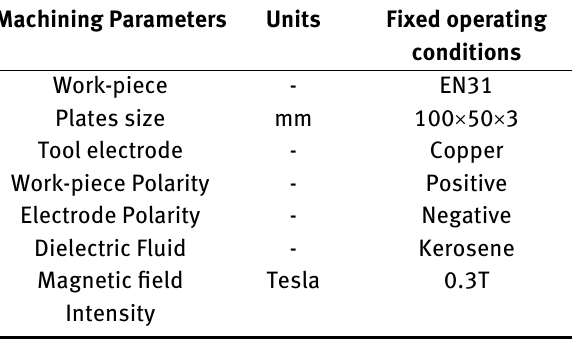
Table 1: EDM fixed